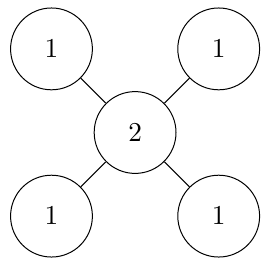
Figure 2 . The ( N; k ) = (2 ; 4)